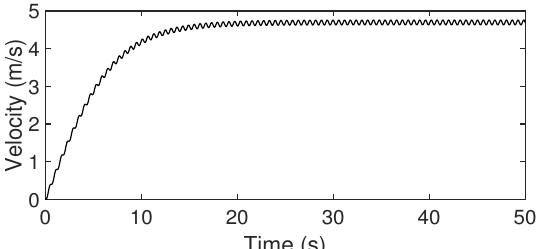
Figure 4. Kayak speed versus time, Square sine force case m = 90 kg, f 0 = 120 N, d = 2.72 kg/m y w = 1.66 · π rad/s (100